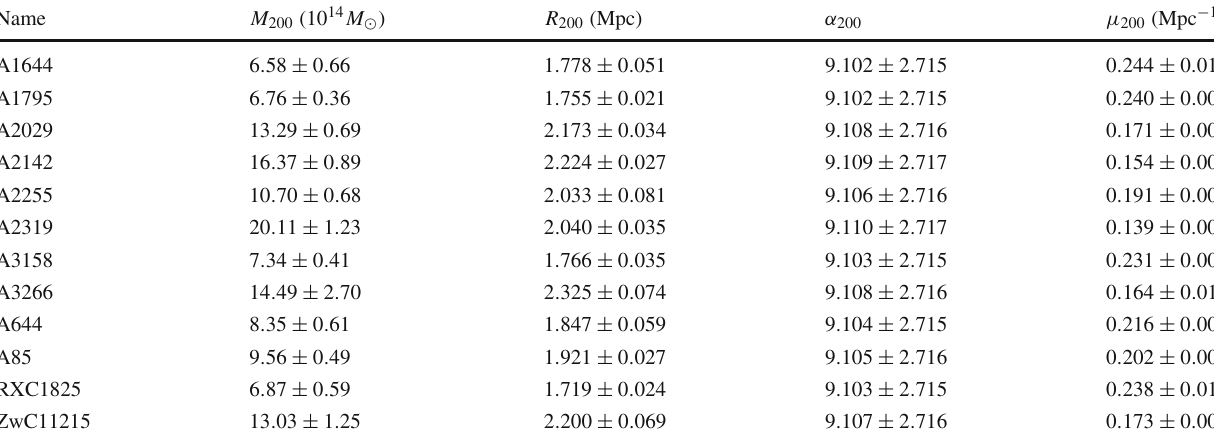
Table 1 Best fit values for α 200 and μ 200 estimated for X-COP cluster